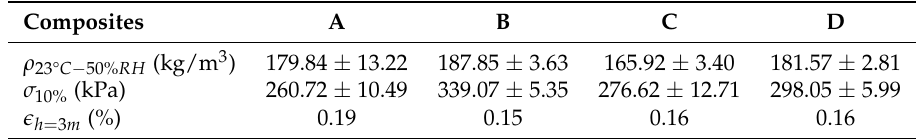
Figure 10. Stress at 10% deformation versus apparent density at 23 °C and 50%RH of composites. Table 4. Stress at 10% deformation for each